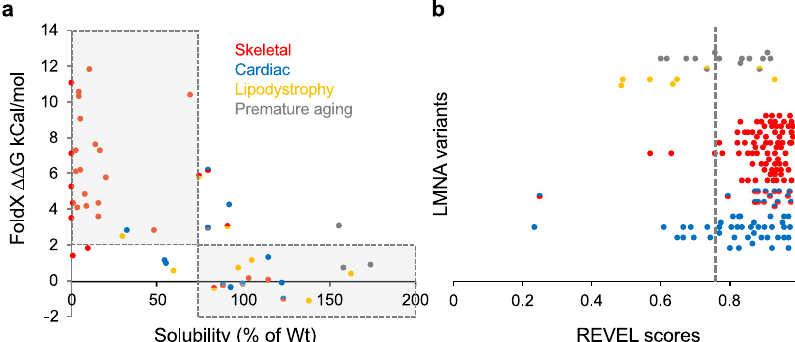
Fig. 5 In silico analysis of LMNA variants. a Comparison of FoldX and IgD solubility data was reported herein using stability cutoffs of ΔΔ G ≤ 2 for FoldX and ≥ 75% of WT for solubility. The shaded area highlights variants that agree. Color code: cardiac (blue), skeletal (red), lipodystrophy (yellow) and premature aging (gray). b Dot plot showing REVEL score distribution of variants with myopathic disease variants (red and/or blue dots) that are not in the gnomAD control population (137 total) compared to all lipodystrophy and/or progeria variants without myopathic crossover disease (yellow and/or gray dots) (20 total). Some myopathic variants also have lipodystrophy/progeria but were not color-coded for simplicity. Variants above the threshold of 0.76 (dashed line) are considered deleterious. IgD immunoglobulin-like domain.